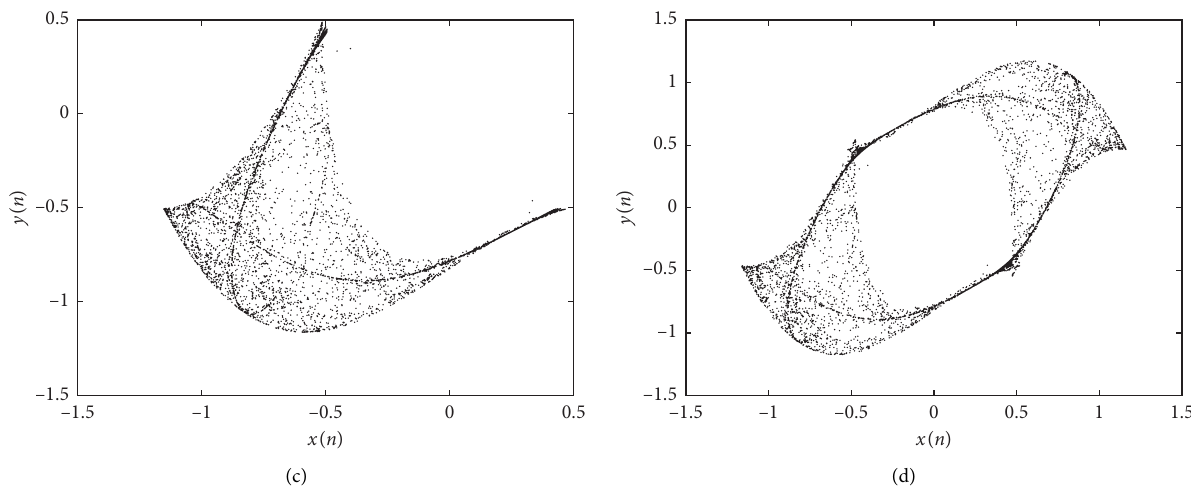
Figure 5: The phase diagrams of system (10) with the initial condition x x ( n ) with c � 0 . 20, (c) c � 0 . 80, and (d) c � 0 .